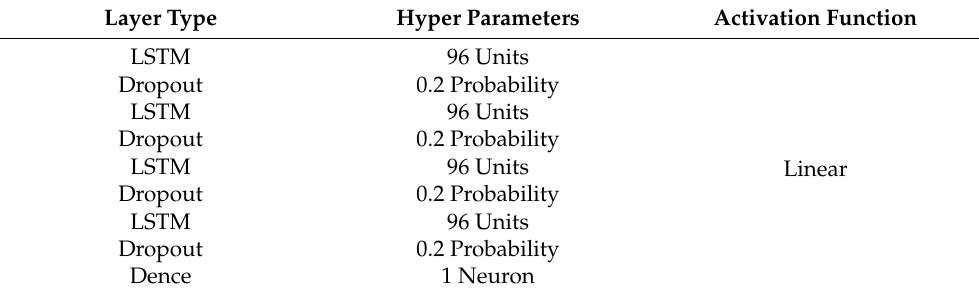
Table 2. LSTM Neural Network